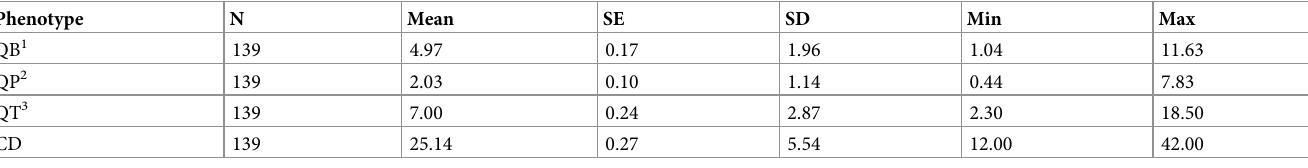
Table 1. Basic statistics of phenotype data for eggshell